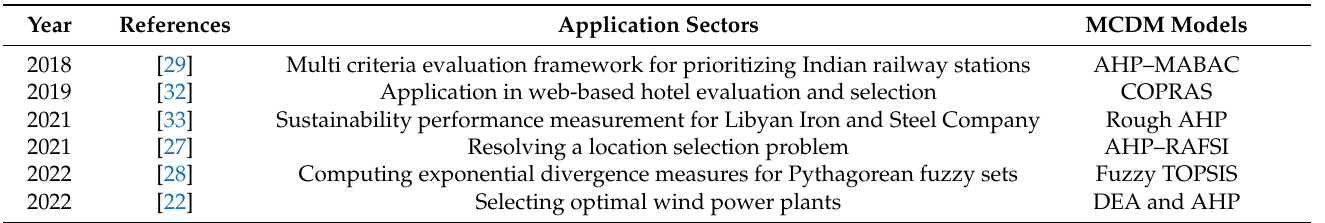
Table 1. Literature review of MCDM